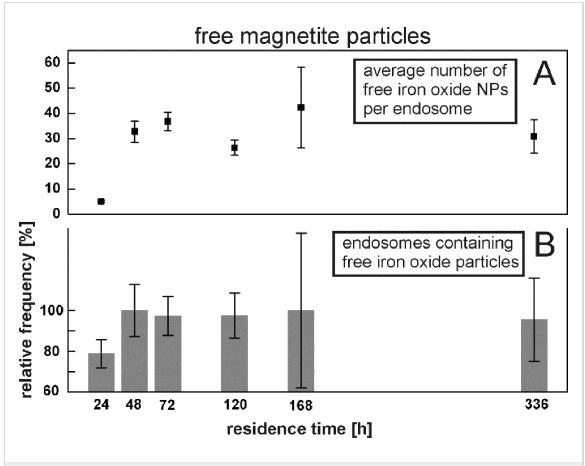
Figure 9: Quantitative analysis of TEM micrographs as to the occur- rence of free magnetite nanocrystals. Average number of free magne- tite nanocrystals per endosome (A) and relative proportion of endo- somes containing at least one free magnetite nanocrystal